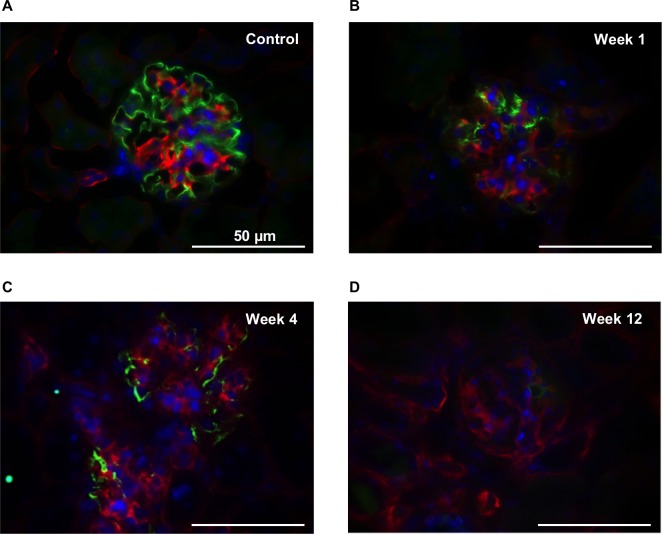
Progressive loss of glomerular podocin abundance in the course of disease.Podocin (green), nidogen (red) and nucleus (blue) staining of glomeruli of healthy and Nphs2R140Q/- animals. (A) Normally expressed podocin in glomerulus of a healthy animal. (B) Partial podocin loss one week after the induction. (C) Immense podocin loss in Nphs2R140Q/- animals four weeks after the induction. (D) Subtotal to total podocin loss at the end stage disease. Magnification, X640.